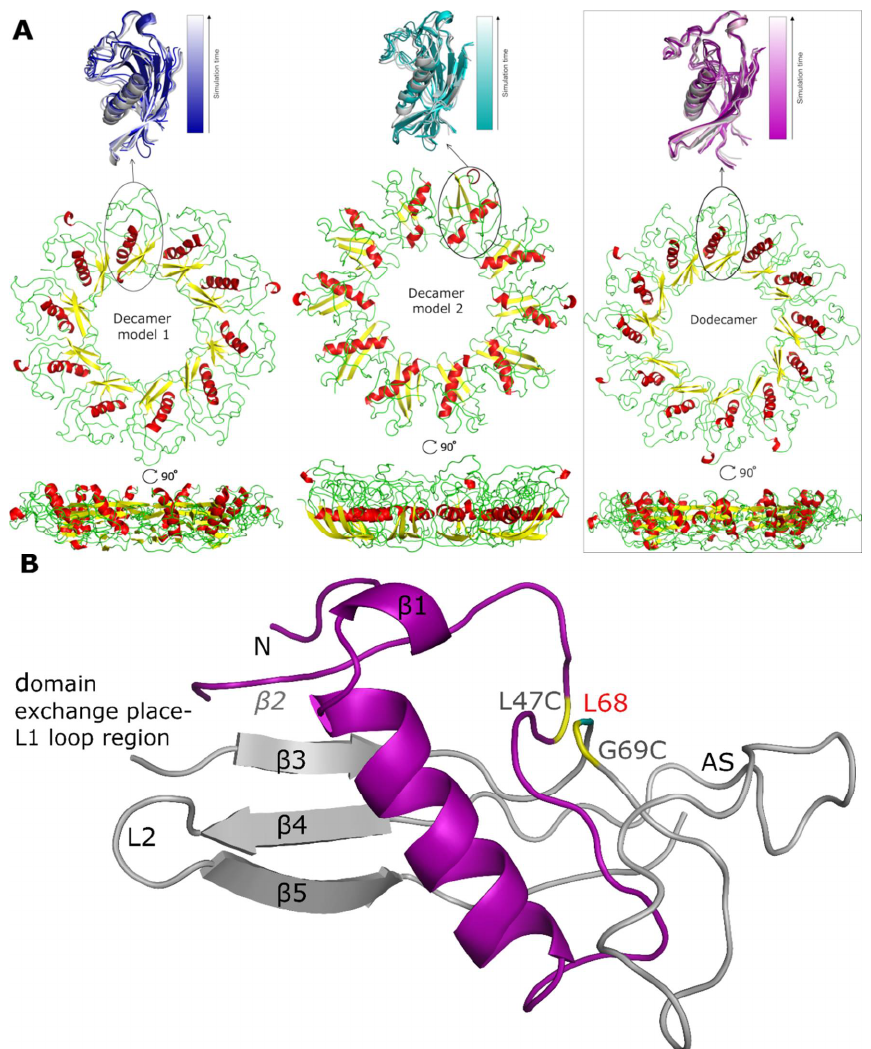
Figure 4. Models of the stab-1 HCC oligomers after MD simulations. ( A ) Final models of HCC: decamers (left—model 1, center—model 2) and dodecamer (right) obtained in the MD simulations. An enlargement of one subunit within the initial models (color) is superimposed onto the final structures (grey). ( B ) An HCC monomer-like subunit from the dodecamer model after MD simulations, labelled with the locations of the secondary structure elements as found in the crystal structure. The oligomer molecule is formed after a domain exchange: main chain 1—light gray, main chain 2—purple. In the crystal structure, there is an additional disulfide bridge (L47C-G69C) linking β 2 sheet with β 3 sheet (residues indicated in yellow) and the position of residue L68 is labelled in red; this is the location of the pathogenic mutation, L68Q. The appending structure (AS) is the broad random-coil region between the β 3 and β 4 sheets